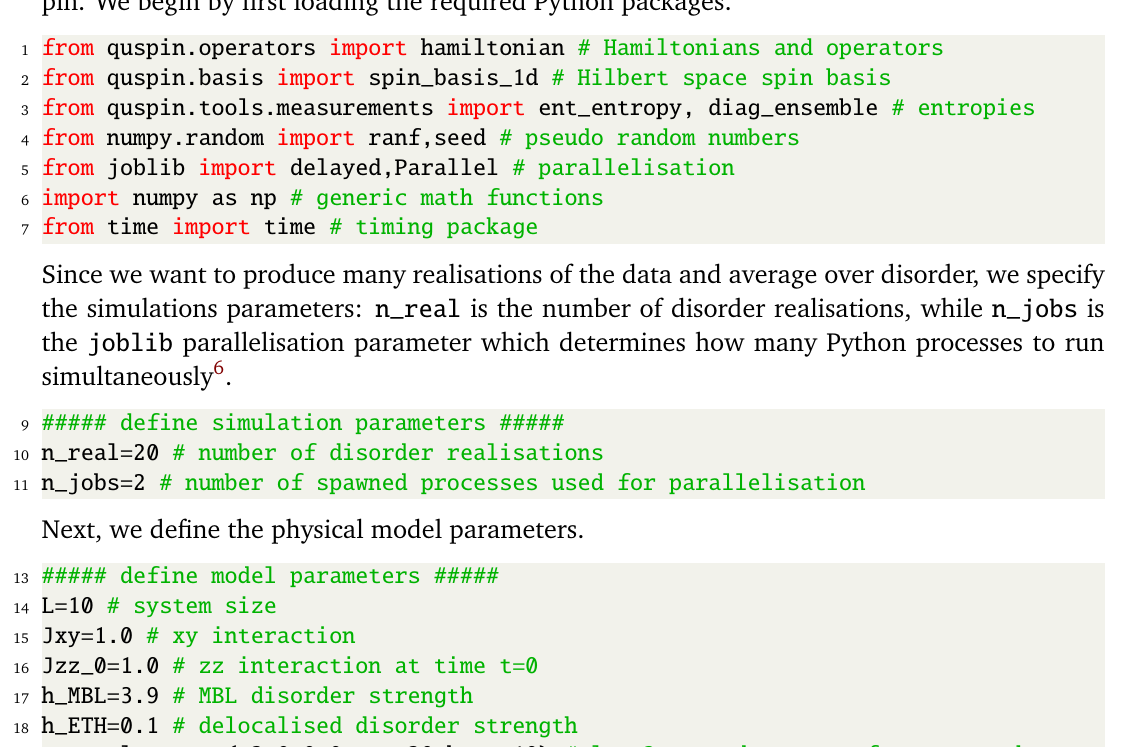
/ J ( 0 ) = 1.0, h / J ( 0 ) = 3.9, x y zz zz MBL